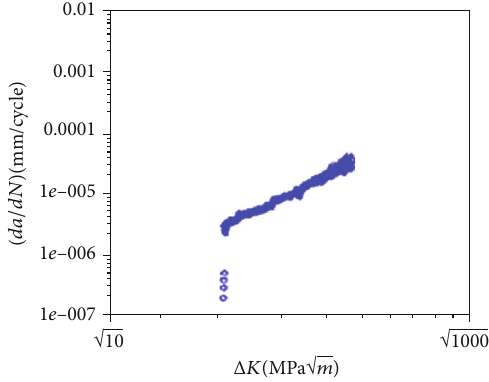
Figure 13: Crack growth rate of 1Cr11Ni2W2MoV ( R = 0 : 8